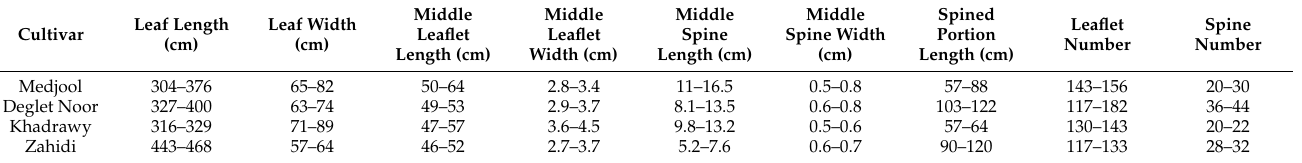
Table 1. Value ranges of the morphological characterization of four date palm cultivars grown in